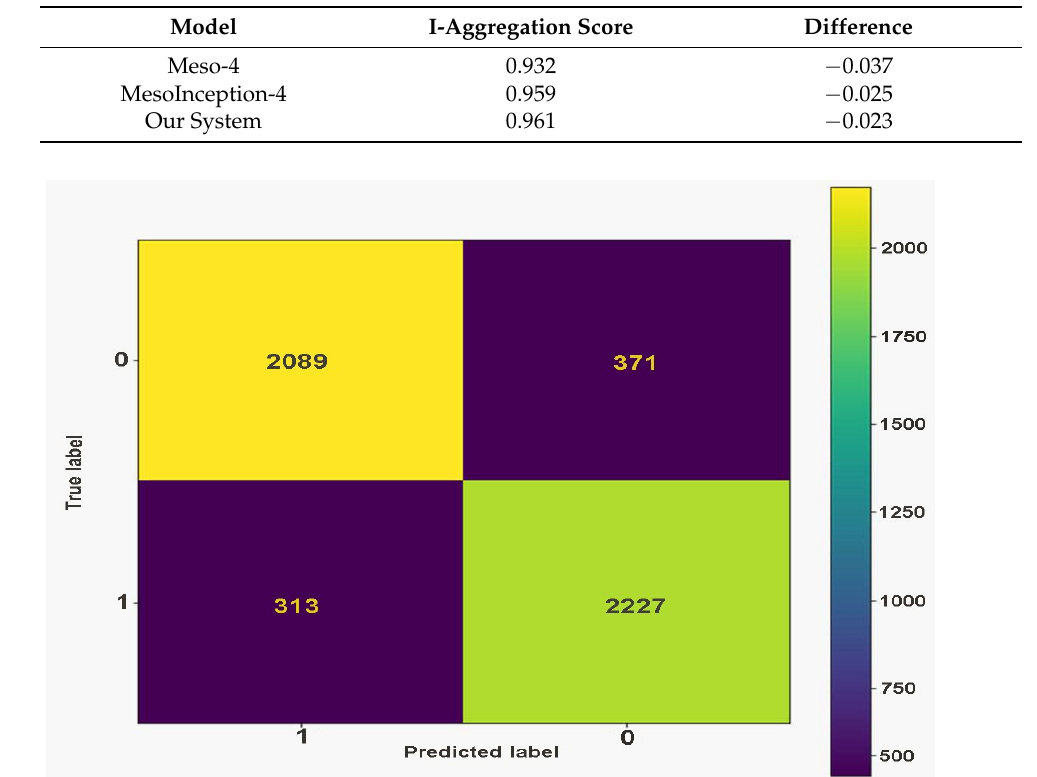
Table 7. I-frames classification score variation on the DeepFake dataset.